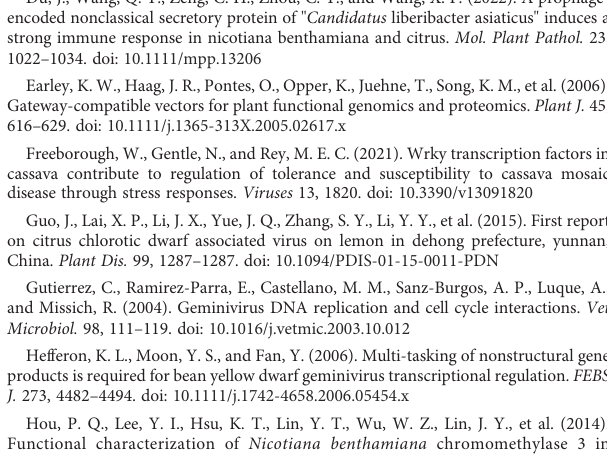
SUPPLEMENTARY FIGURE 4 Effect of signaling cascade component silencing on RepA-induced cell death in Nicotiana benthamiana . The expression of NbWRKY1 was calculated using the formula 2 − DD Ct with the housekeeping gene, NbACTIN (Student ’ s t-test ** p <